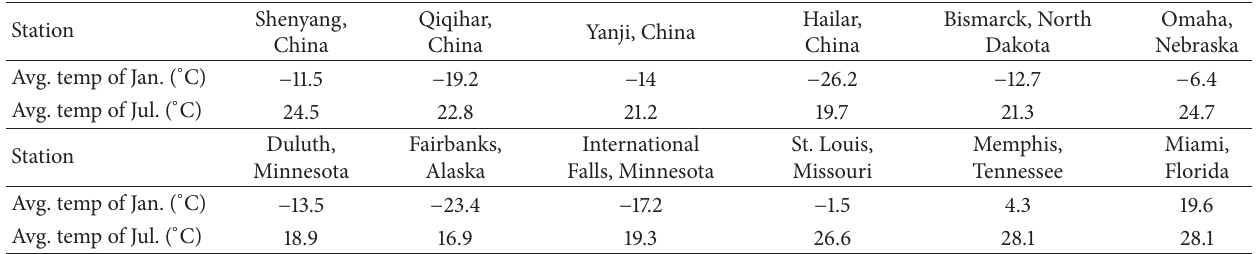
Table 4: Average temperatures in climate station [23].